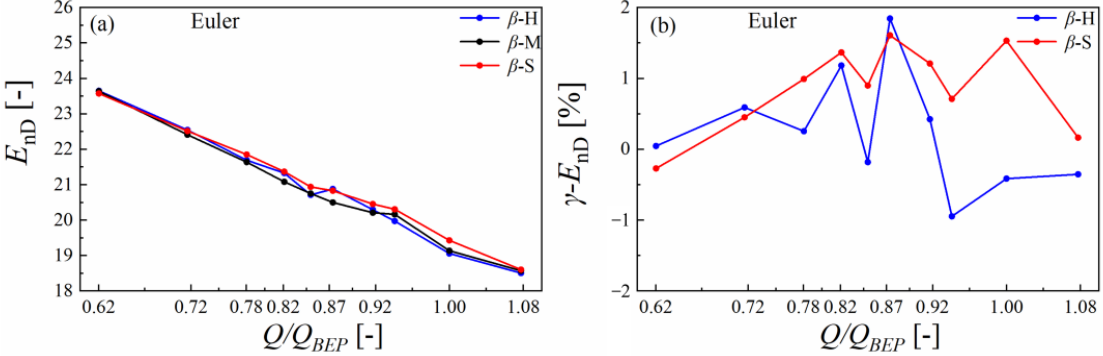
Figure 10. Distribution of Euler head at different plans and relative change rates.